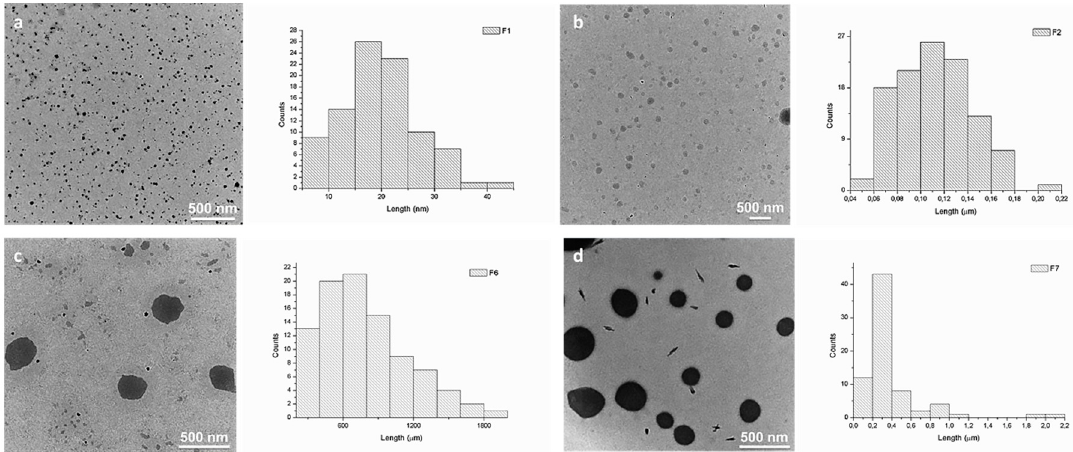
Figure 4. TEM images and corresponding average size distributions of the synthesized DCFs in water: ( a ) F1 (~30 nm); ( b ) F2 (~100 nm); ( c ) F6 (~500 nm); and ( d ) F7 (~300 nm).